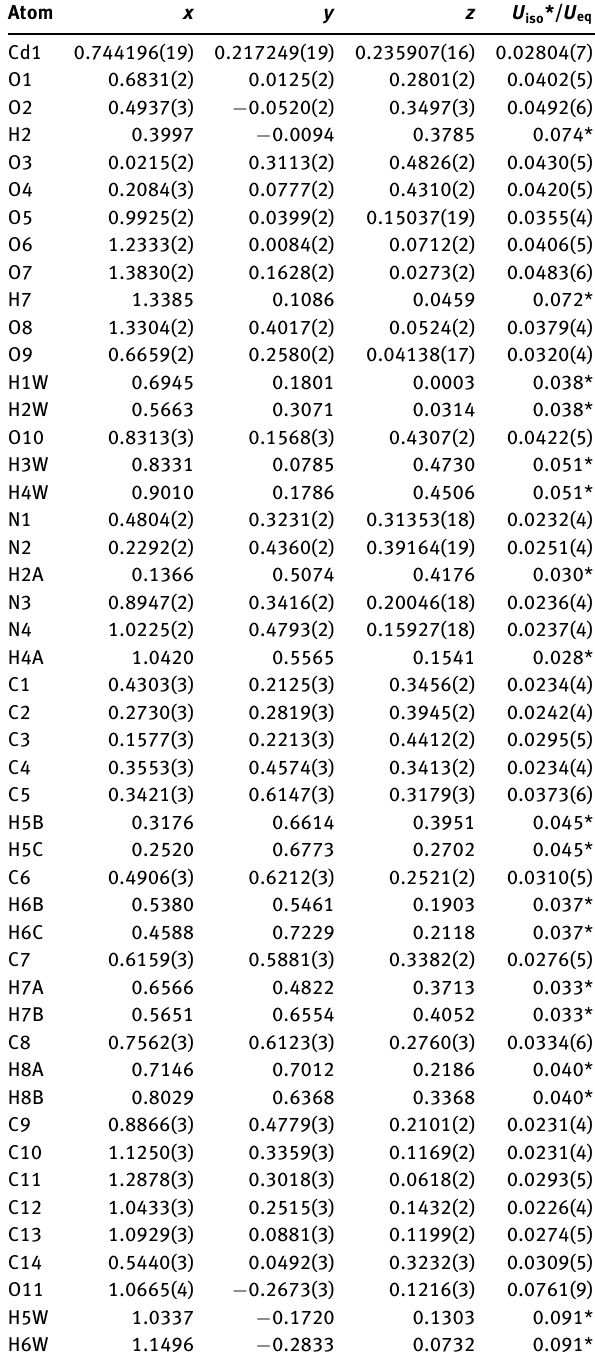
Table 2: Fractional atomic coordinates and isotropic or equivalent isotropic displacement parameters (Å 2